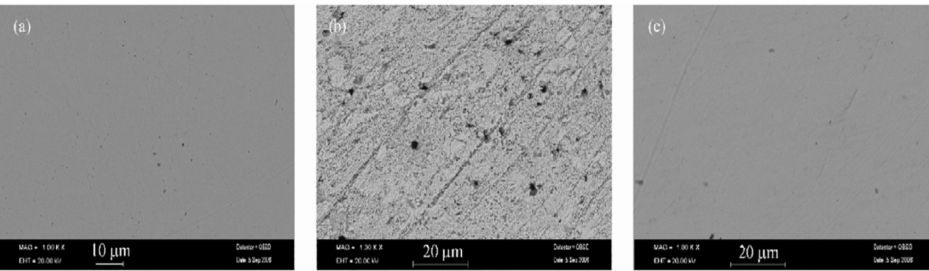
Figure 5. SEM of mild steel ( a ) after polishing, ( b ) after immersion in 1.0 mol · L − 1 HCl and ( c )